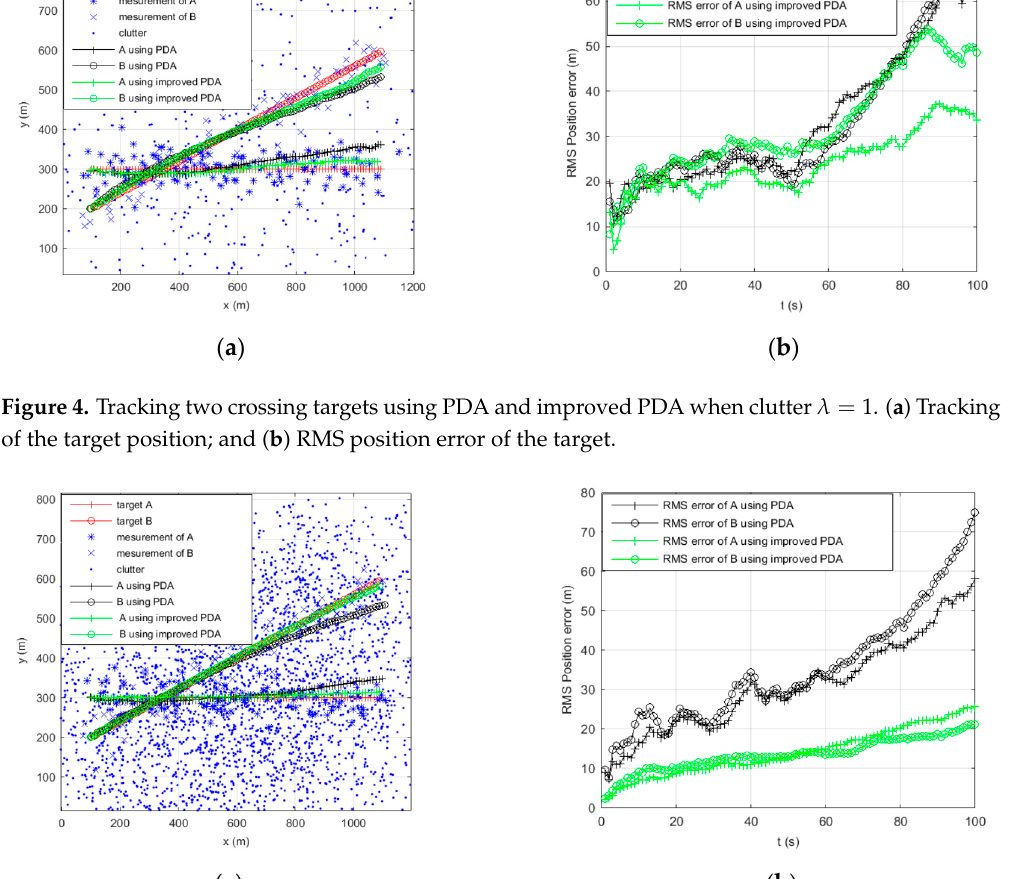
( b ) Figure 6. Maneuvering target tracking using C-IMM-PDA and improved C-IMM-PDA when clutter 1  . ( a ) Tracking of the target position; and ( b ) RMS position error of the target.